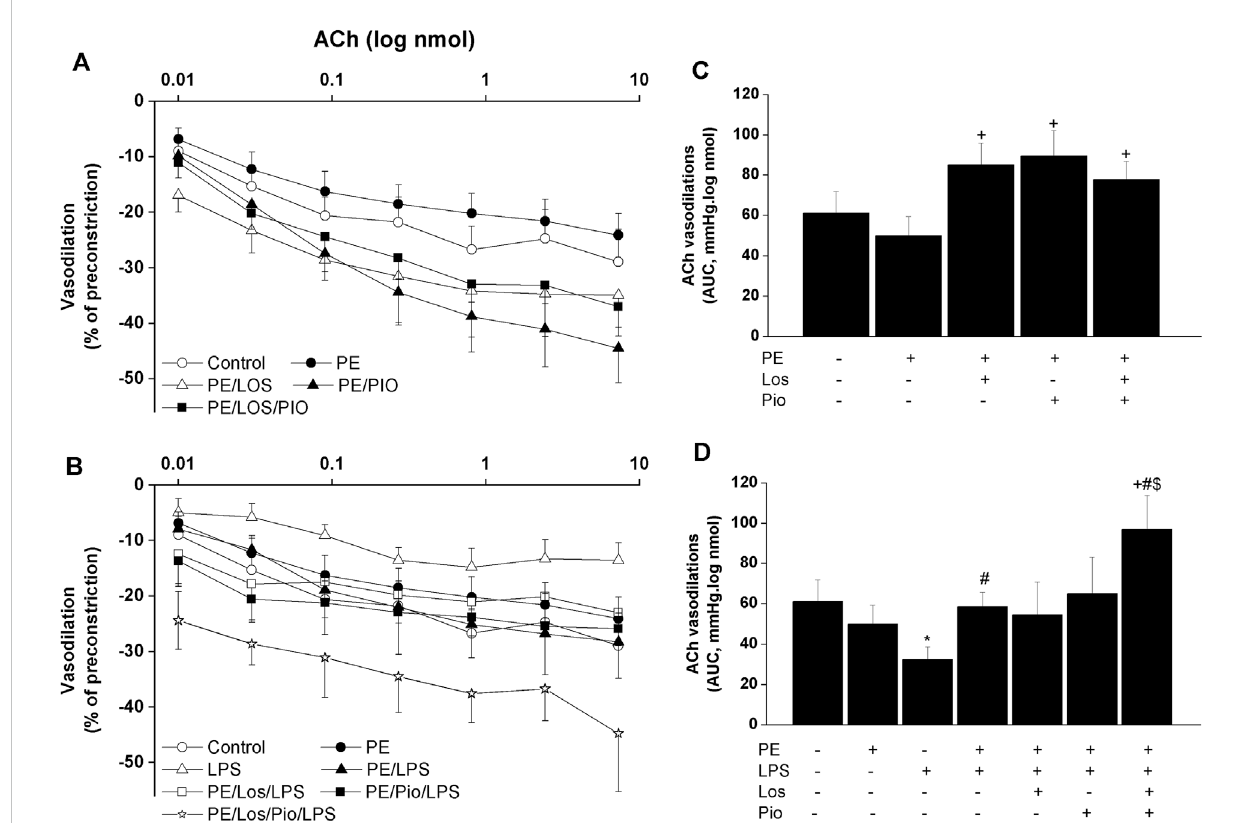
FIGURE 4 Effectofgestational losartanand/orpioglitazonetherapyoncumulativevasodilatory doseresponsecurvesofACh(panels A,B )andAUCs(panels C, D ) of the ACh vasodilatory dose response curve in phenylephrine preconstricted isolated perfused kidneys in male offspring of PE or PE/LPS dams. Data are expressed as the mean ± SEM of 7-8 measurements. ANOVA followed by the Tukey ’ s post hoc was utilized to measure statistical signi fi cance. * p < 0.05 vs. “ Control ” , + p < 0.05 vs. “ PE ” , # p < 0.05 vs. “ LPS ” and $ p < 0.05 vs. “ PE/LPS ”